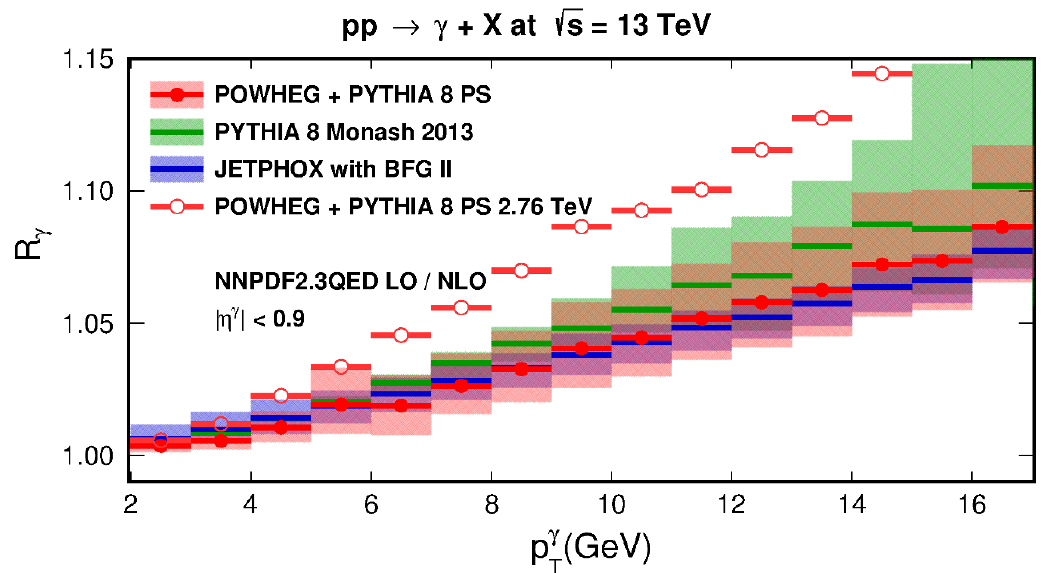
Figure 8 . Ratio of inclusive over decay photon production in pp collisions at the LHC with a p centre-of-mass energy of s = 13 TeV. LO predictions with PYTHIA (green) are compared to those at NLO with JETPHOX (blue) and NLO+PS with POWHEG+PYTHIA (red, full circles). p The latter are also shown at s = 2 : 76 TeV (red, open